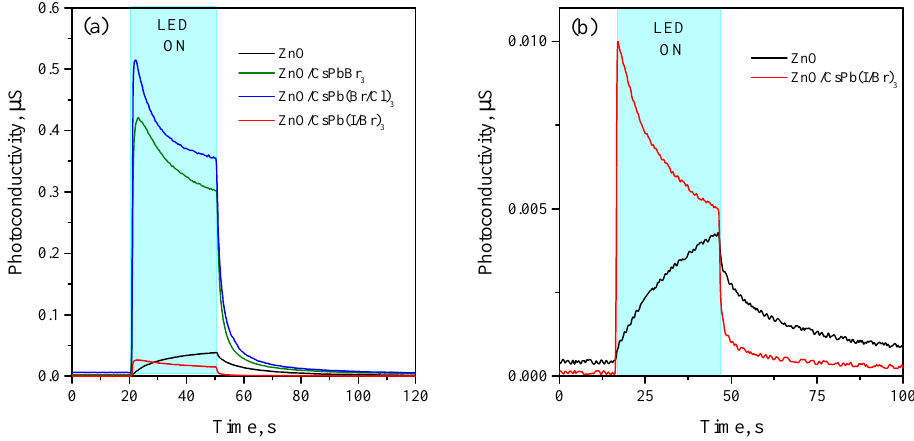
Figure 8. ( a ) Rise and decay curves of photoconductivity of unsensitized ZnO and ZnO/PNCs nanocomposites under blue LED irradiation ( λ max = 470 nm, 13 mW/cm 2 , 30 s) at room temper- ature; ( b ) Rise and decay curves of photoconductivity of unsensitized ZnO and ZnO/CsPb(I/Br) 3 nanocomposite under green LED irradiation ( λ max = 525 nm, 13 mW/cm 2 , 30 s) at room